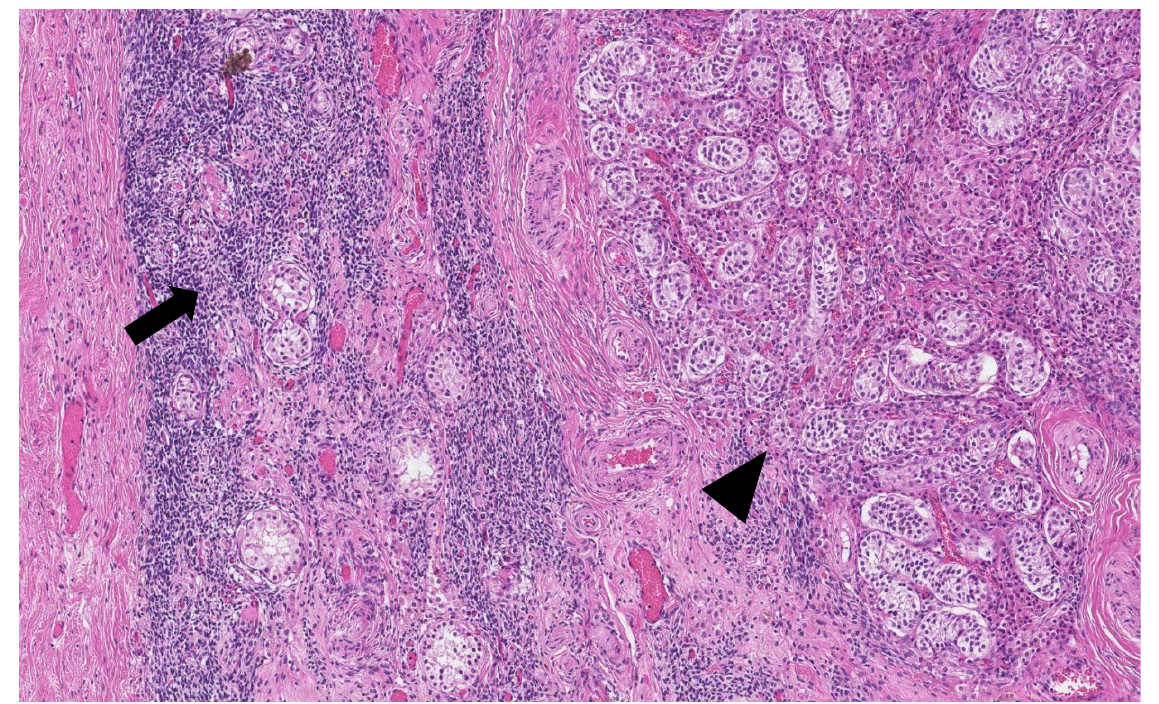
Figure 4. Ovarian-type stroma (arrow) and tubules composed of immature Sertoli cells separated by Leydig cells (arrowhead) (H&E staining, ×50).